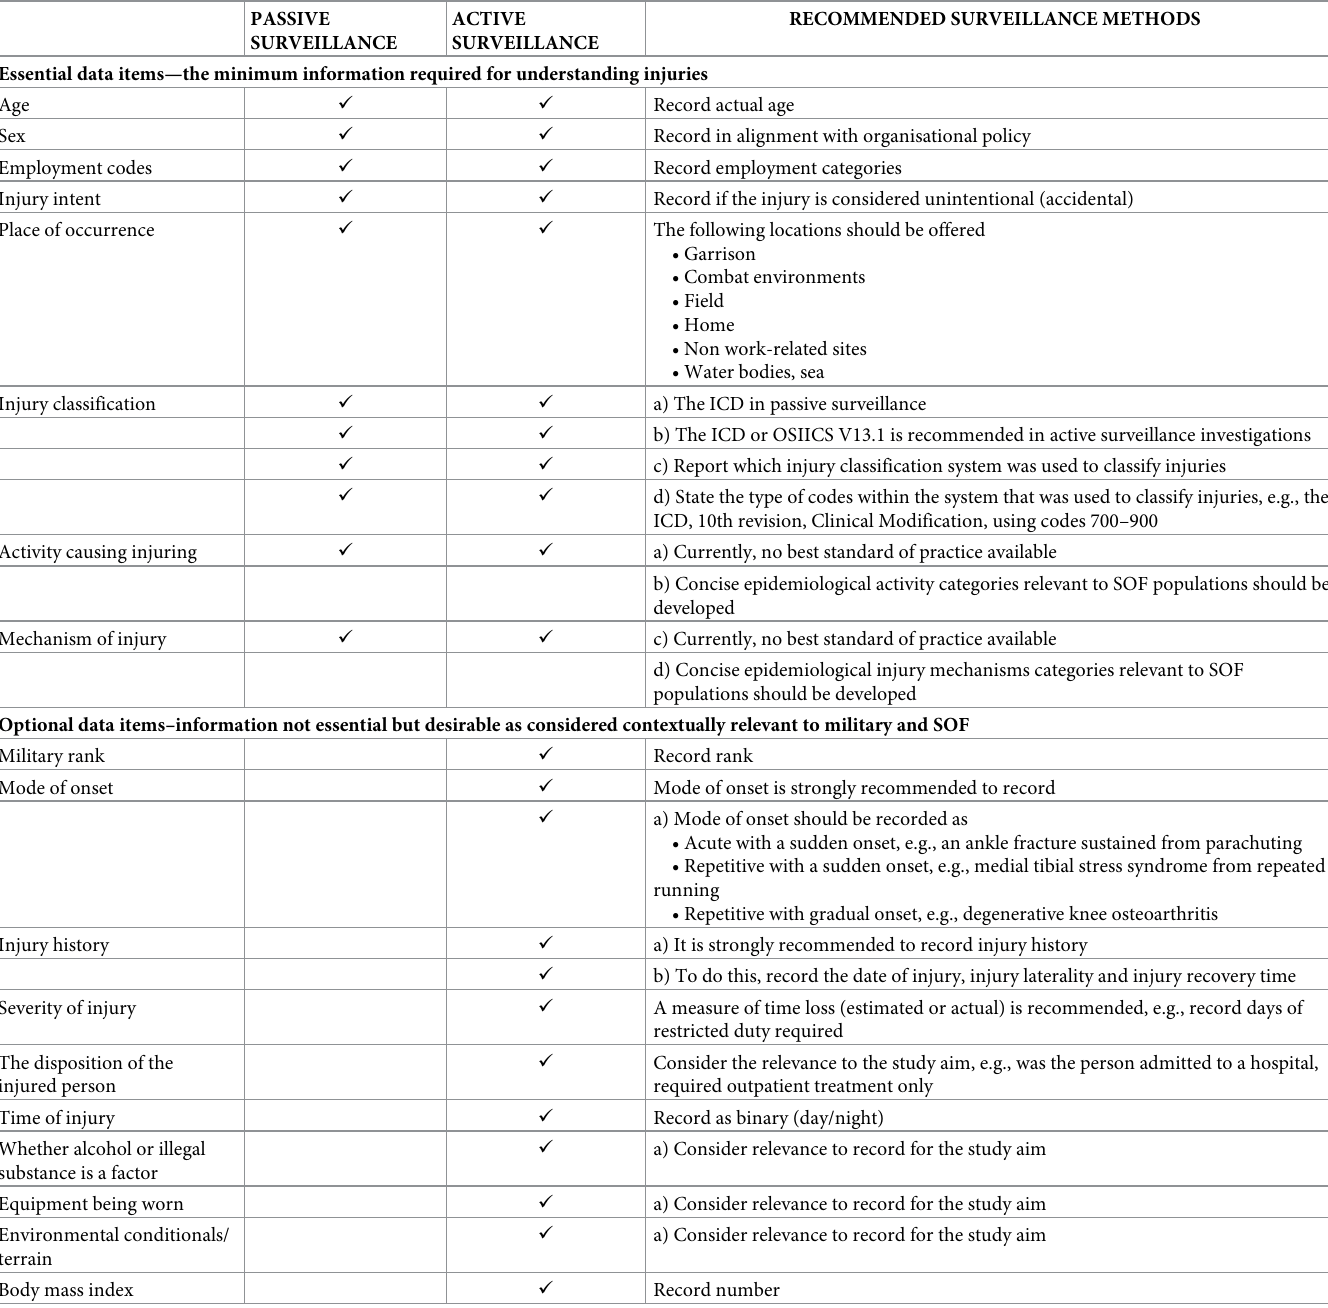
RECOMMENDED SURVEILLANCE